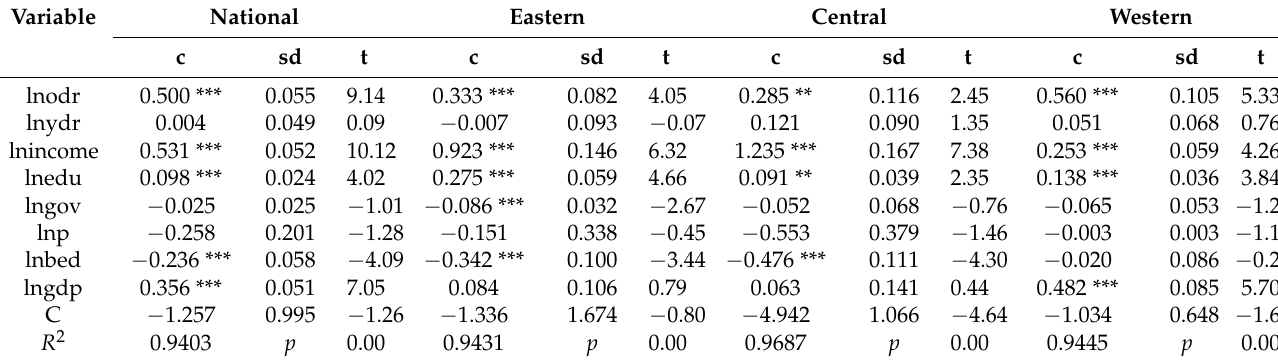
Table 4. Regression results of fixed effect model in